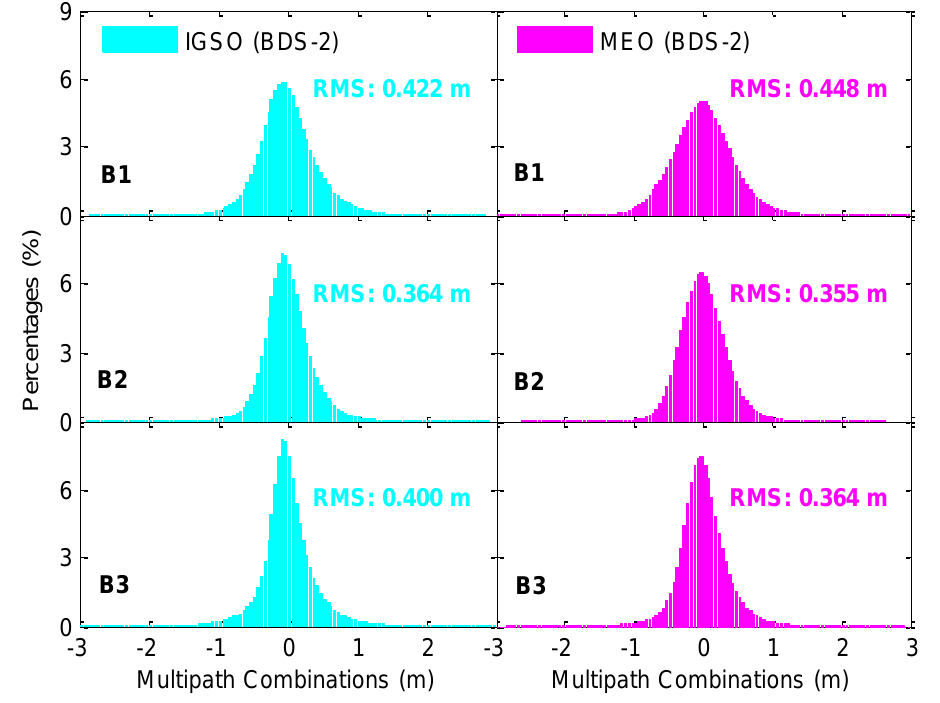
Figure 16. Distribution of corrected MP combination time series with the traditional SICB correction model for BDS-2 IGSO and MEO satellites.